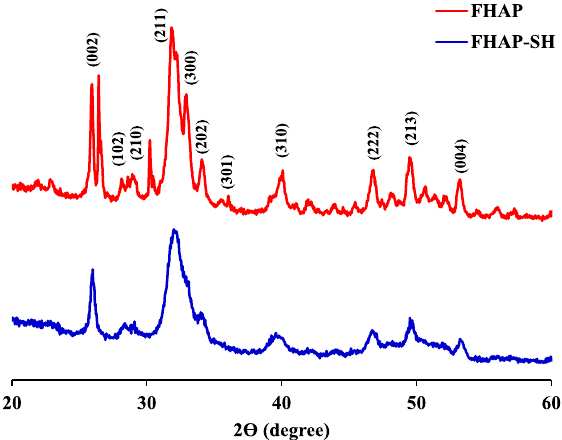
Figure 1. XRD patterns of the FHAP and FHAP-SH.